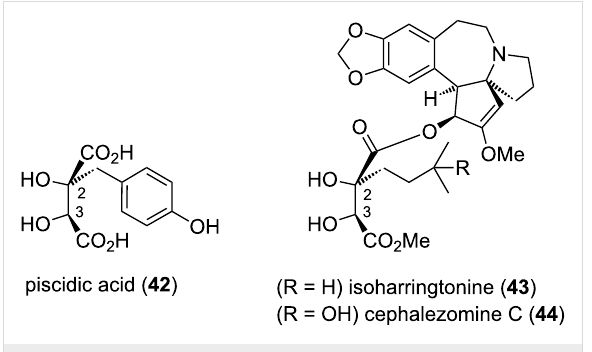
Figure 2: Natural product examples containing the monoalkylated tartaric acid